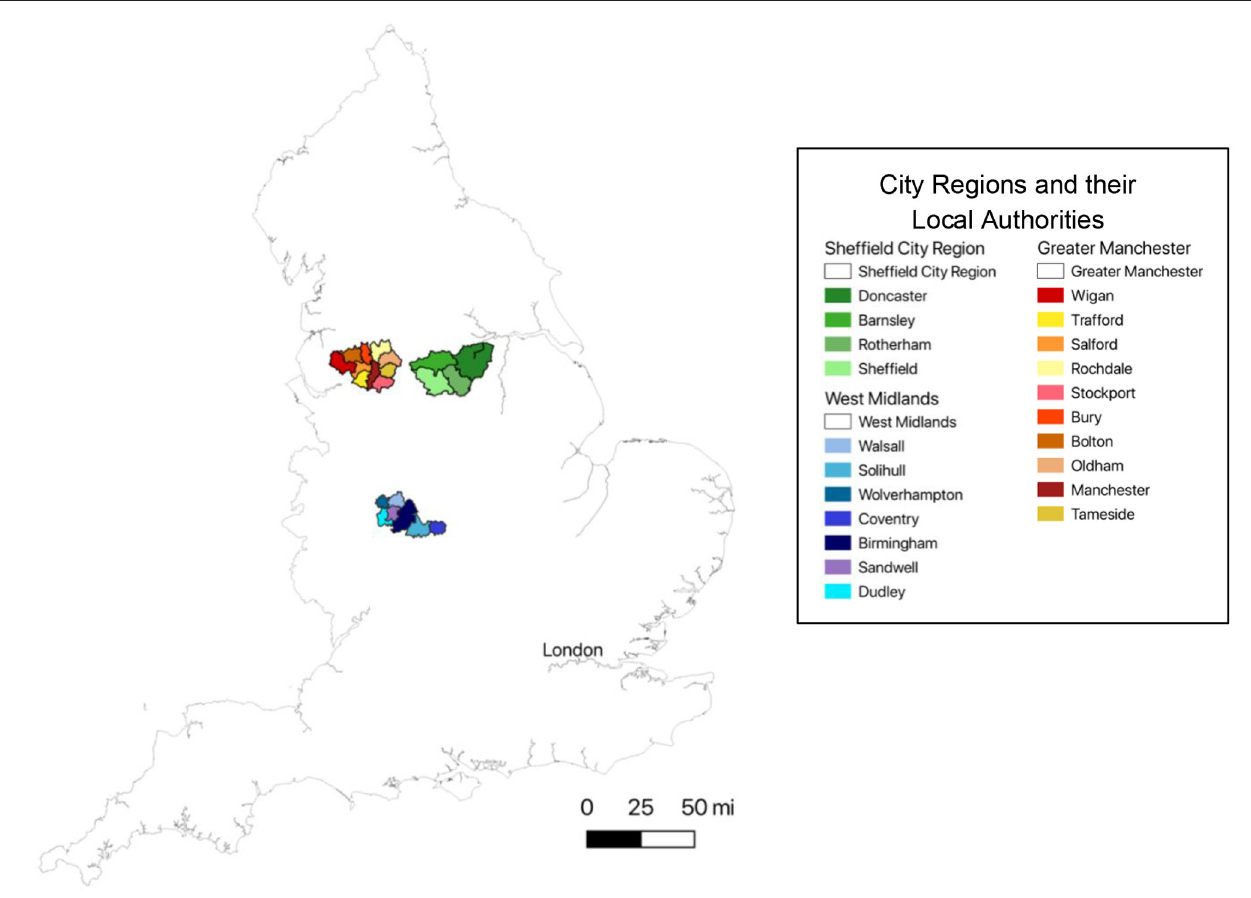
FIGURE 2 | A map showing the combined authority city regions of Greater Manchester, West Midlands, and Sheffield including the local authorities that they are comprised of (Authors